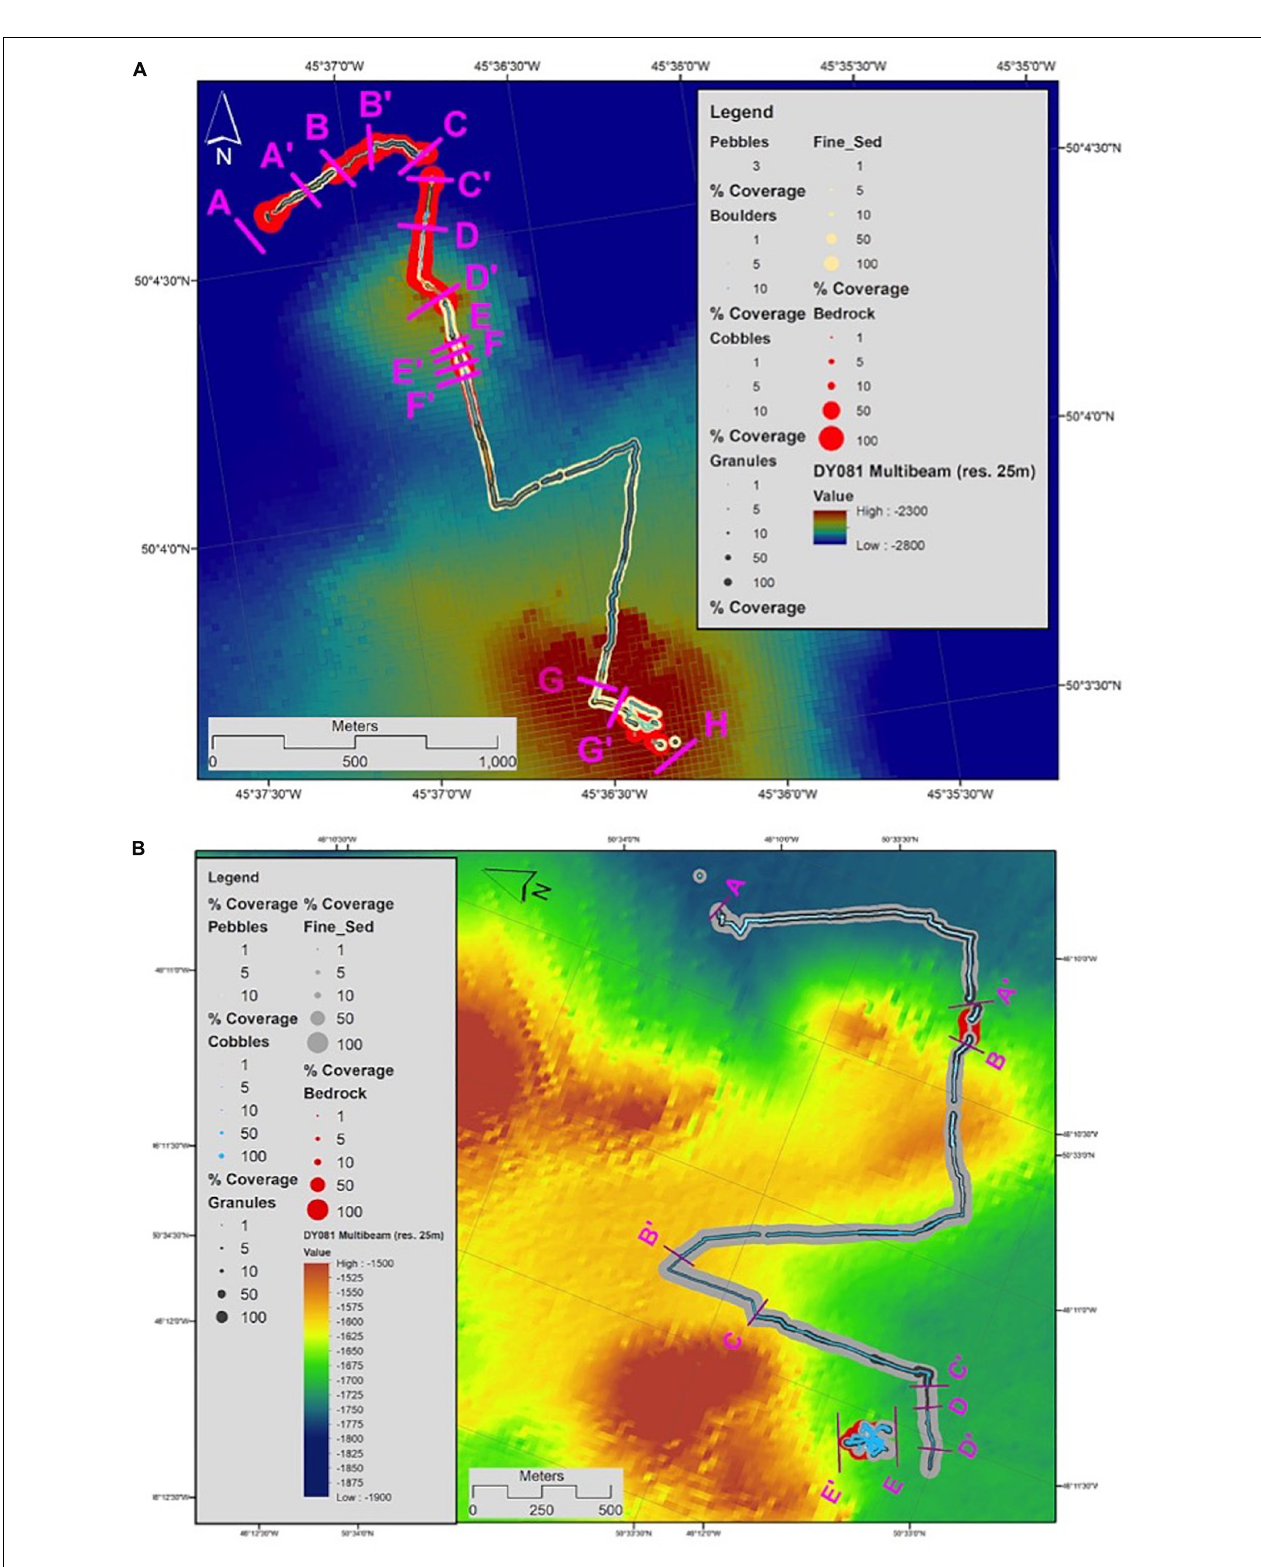
FIGURE 9 | Track of ROV dives, annotated for surficial geology. Bedrock exposure areas are indicated in red. (A) Dive R1341, SE Orphan Knoll. Bedrock areas were found most extensively in segments A–A (cid:48) , B–C, C (cid:48) –D (cid:48) , and G (cid:48) –H. (B) R1343, NE Orphan Knoll. Observations in Figures 8 , 10 are from segment E–E (cid:48) , which was the most carefully mapped segment of bedrock exposure, and was also the site of the subfossil coral graveyard.